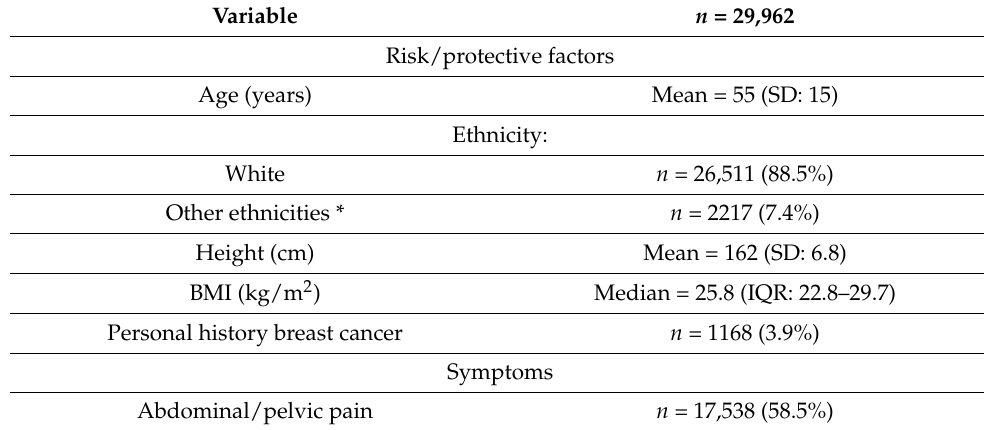
Table 2. Cohort baseline characteristics.